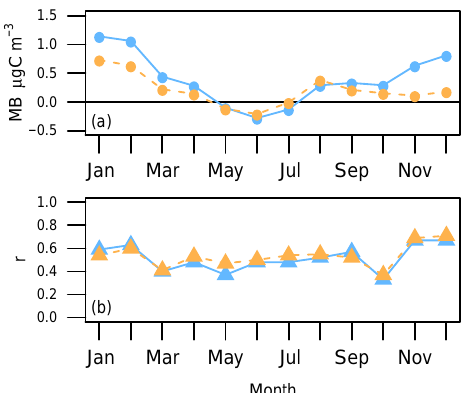
Figure 9. Monthly model performance for the nvPOA (blue) and LEBR (orange) cases throughout the 2011 simulation. The top panel indicates the mean OC bias, while the bottom panel indicates the correlation coefficient of each model run with the CSN and IM- PROVE